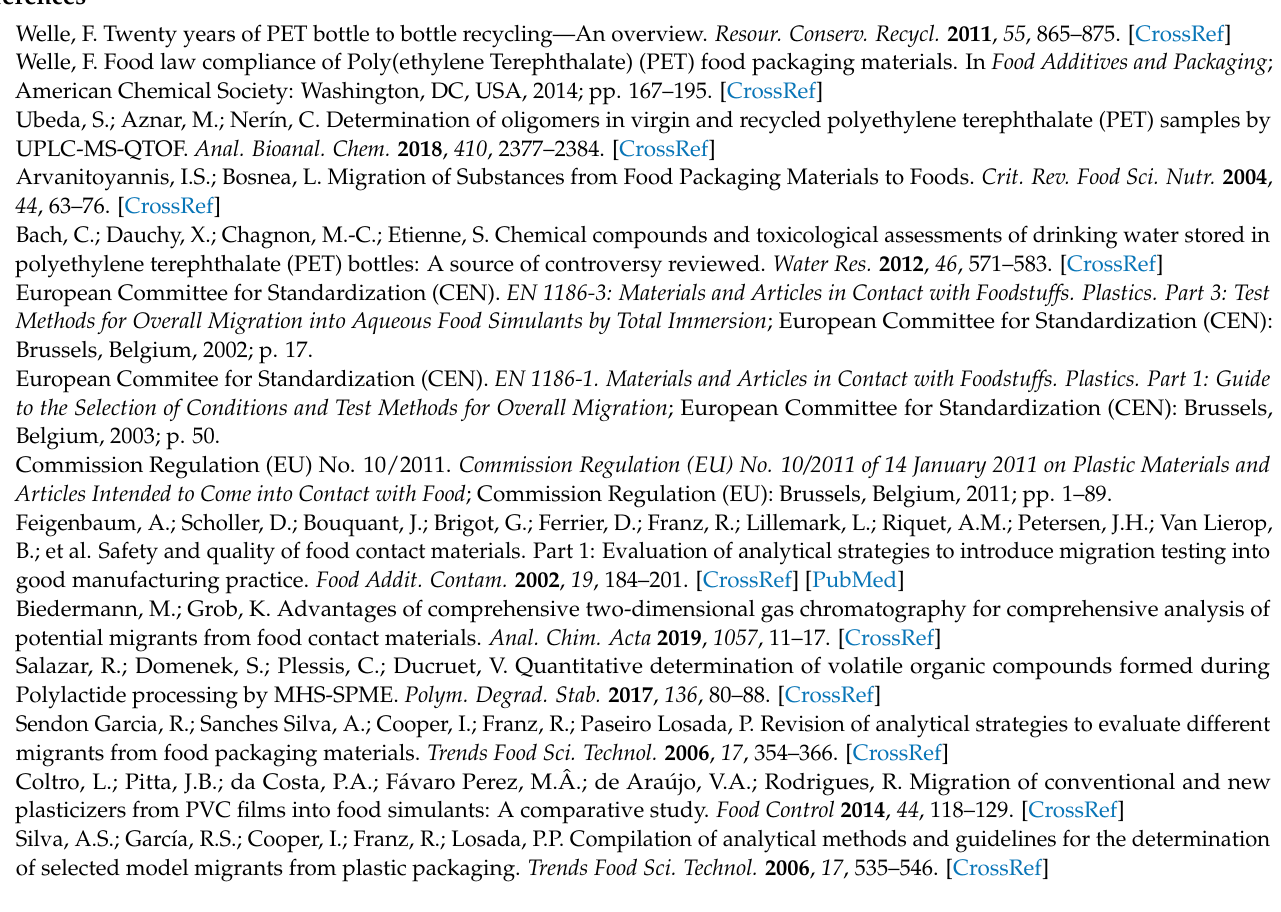
substances found in PET bottles P, Table S2: Unknown substances found in PET bottles T, Table S3: Unknown substances found in PET bottles A, Table S4: Unknown substances found in PET bottles